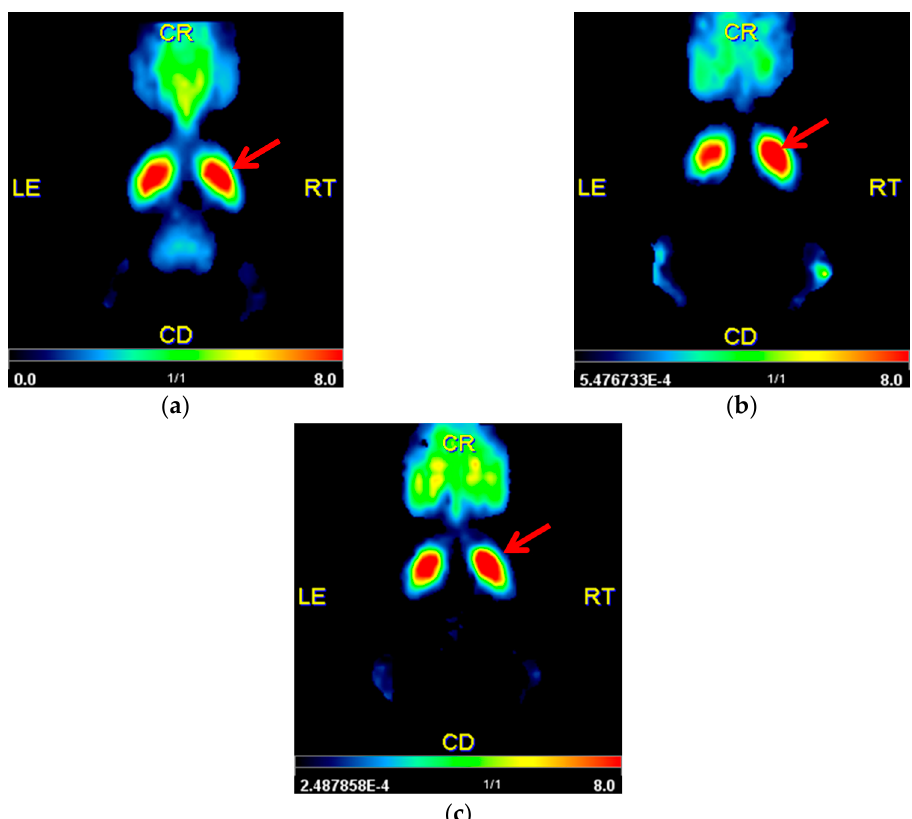
Figure 3. Qualitative analysis using pixel-wised parametric mapping for the parameter BP nd showing the left and right CPu in transversal sections for ( a ) controls (sham-6-OHDA + sham-BoNT-A) ( b ) sham-injected hemi-PD rats (6-OHDA + sham-BoNT-A) and ( c ) BoNT-A-injected hemi-PD rats (6-OHDA + BoNT-A) one month after BoNT-A or sham-BoNT-A injection. A representative animal of each experimental group was used. Controls did not reveal visual side differences, an increased signal of BP nd distribution in the right CPu of hemi-PD rats was clearly visible and BoNT-A injection normalized the increased signal in hemi-PD rats. The right CPu is marked with a red arrow. For quantification the simplified reference tissue model 2 (SRTM2) was applied and BP nd was estimated separately for the left and right striatum. Controls (sham-6-OHDA + sham-BoNT-A) revealed no relative interhemispheric right–left differences: mean BP nd of 4.2 ± 0.8/4.2 ± 0.8